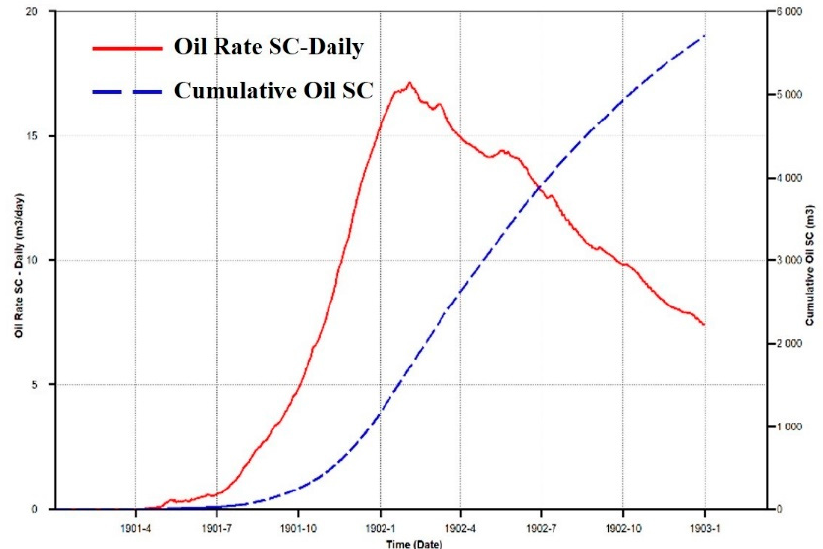
Figure 10. Daily oil production and cumulative oil production (without particle migration).